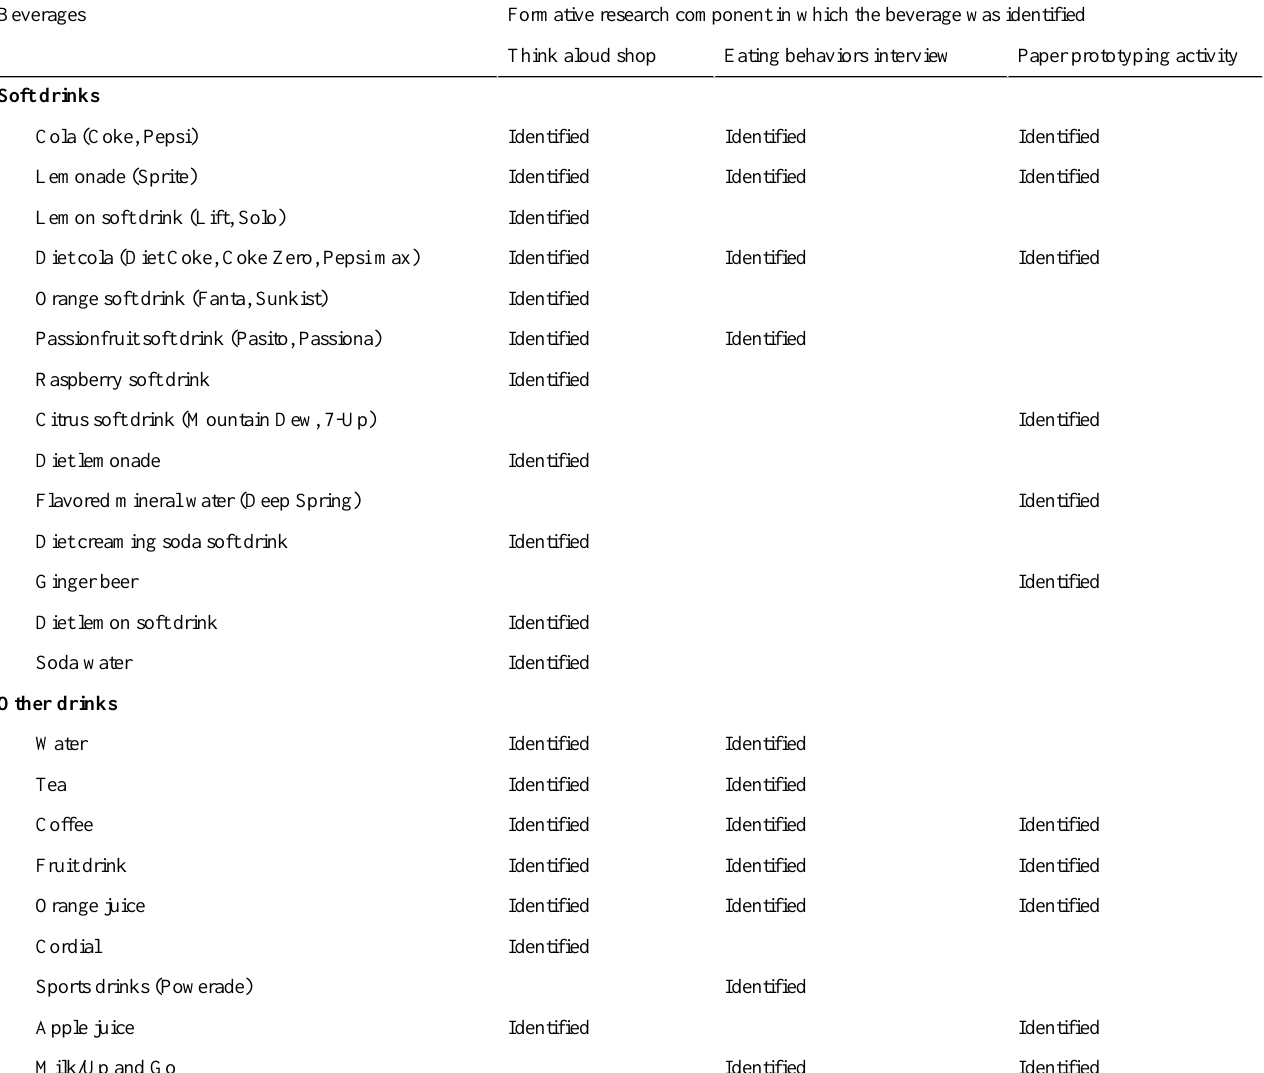
Table 3. Common beverage choices in the remote Indigenous communities studied, ordered by frequency of mention. Formative research component in which the beverage was